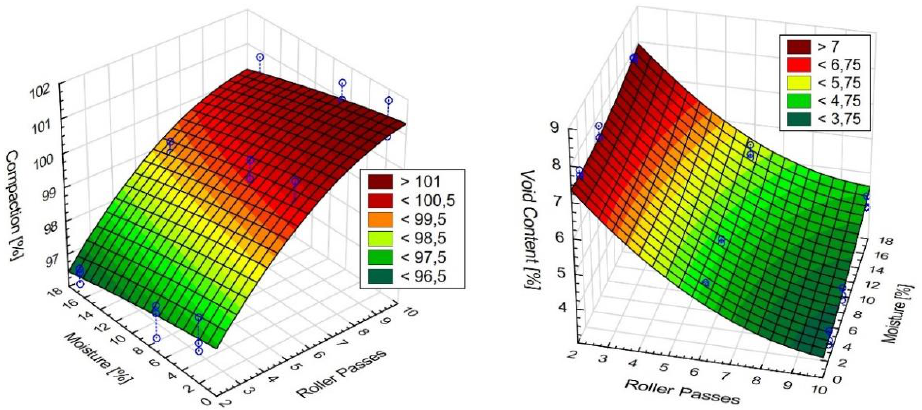
Figure 9. The influence of free space content and compaction on the number of roller passes and soil moisture.